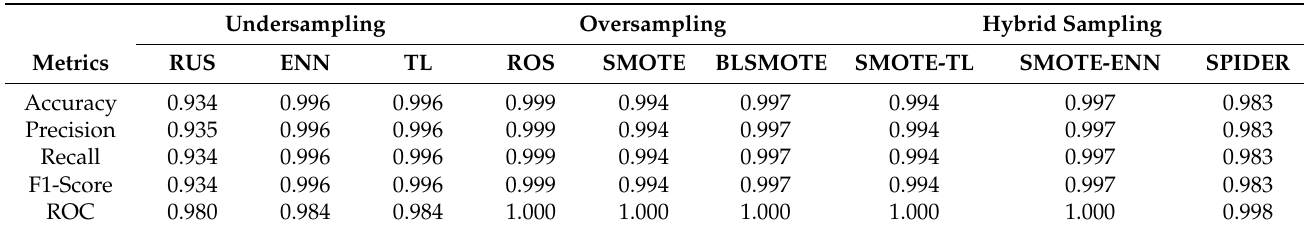
Table 6. Effect of resampling techniques on XGBoost classifier performance.